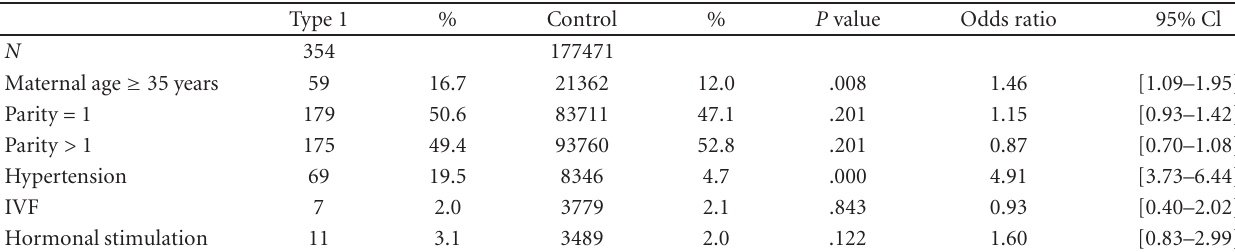
Table 1: Maternal data.